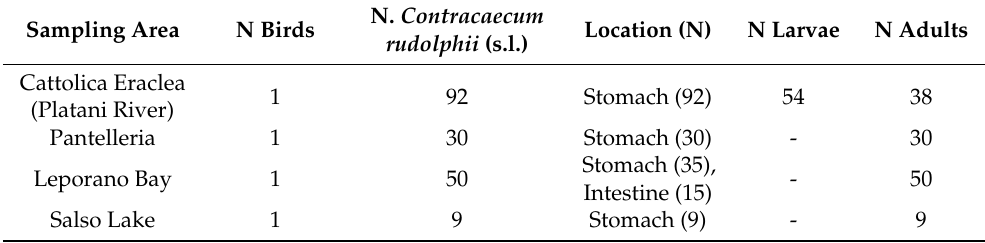
Table 1. Infestation parameters of the C. rudolphii (s.l.) specimens isolated from P. carbo sinensis collected in the sampling areas considered (N: number of specimens).